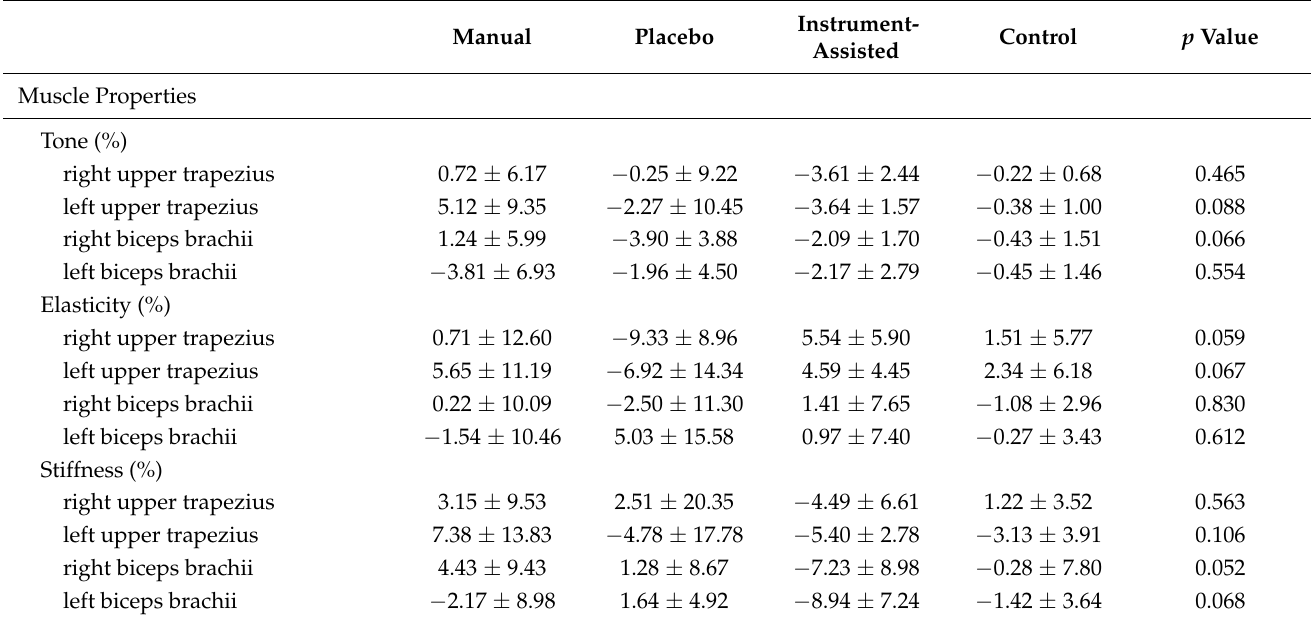
Table 2. Between-groups comparison of the percentage of change from baseline to 15 days after the third session in muscle